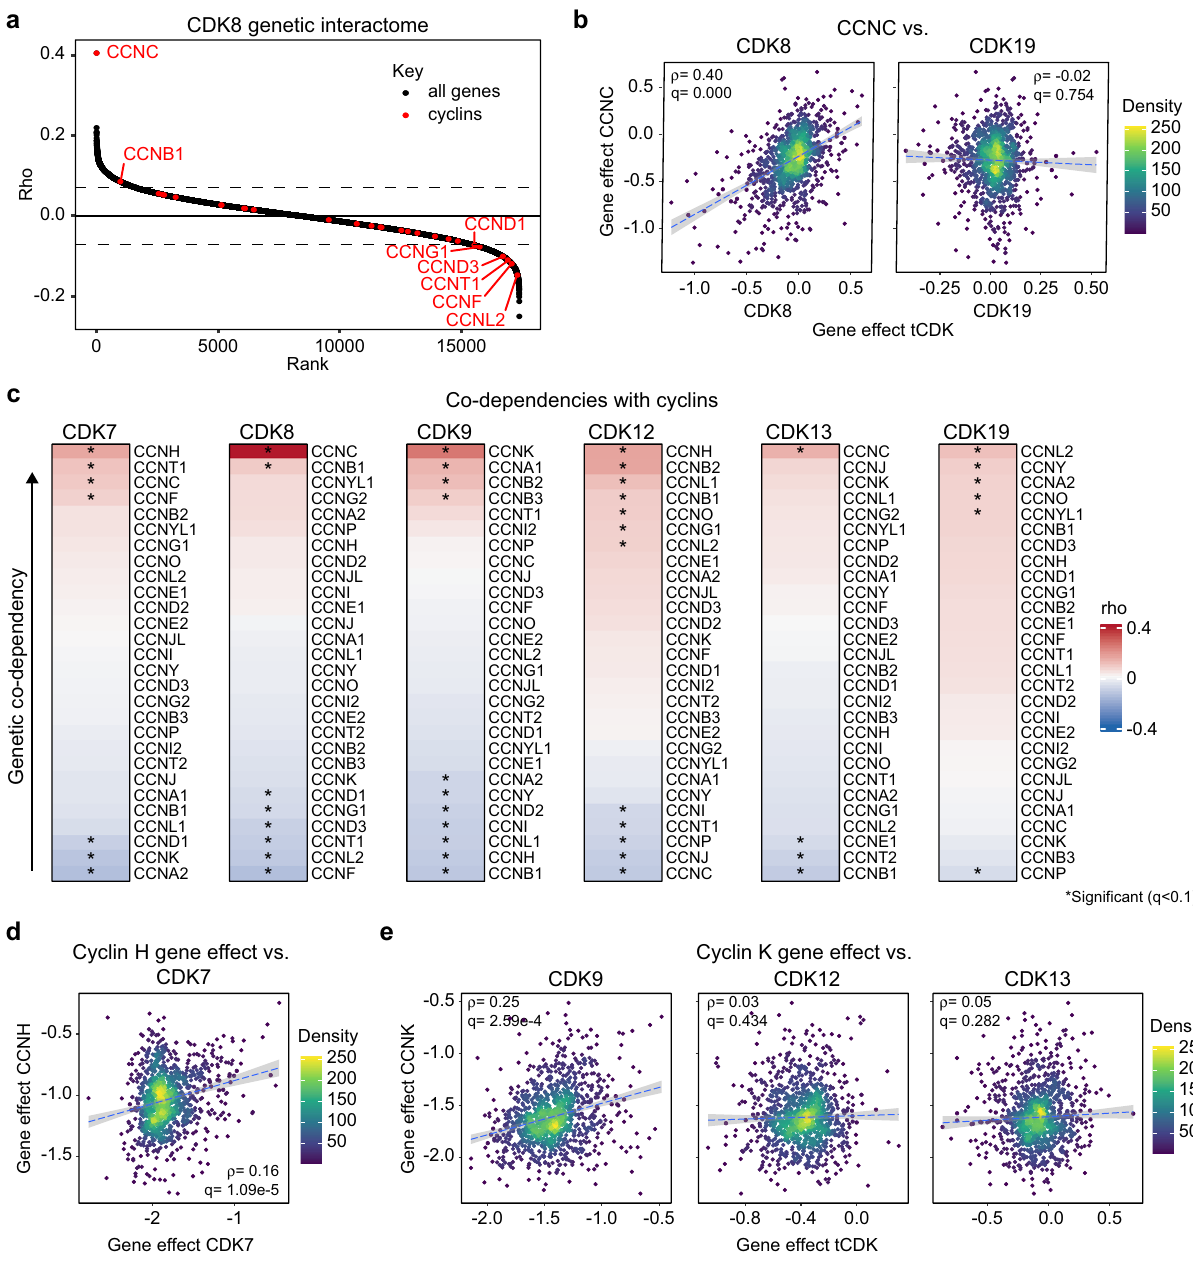
Figure 2. Analysis of genetic co-dependencies reveals predicted versus unexpected relationships between tCDKs and their cyclins. ( a ) Ranked correlations of gene effect scores for CDK8 . Location of all cyclins depicted in red. Above and below the dashed lines denote significant (FDR < 0.1) positive and negative correlations, respectively. Cyclins with significant (FDR < 0.1) correlations are annotated by name. ( b ) Scatter plot showing gene effects of CDK8 and CDK19 versus gene effects of CCNC across all 1070 cell lines in the DepMap data set. ( c ) Ranked gene effect correlations between tCDKs and all cyclin genes in the DepMap dataset. Asterisks denote significant (FDR < 0.1) interactions. Arrow shows higher correlation values equate to higher co-dependency scores. ( d ) Scatter plot showing gene effects of CDK7 versus gene effects of CCNH across all 1070 cell lines in the DepMap data set. ( e ) Scatter plot showing gene effects of CDK9 , CDK12 and CDK13 versus gene effects of CCNK across all 1070 cell lines in the DepMap data